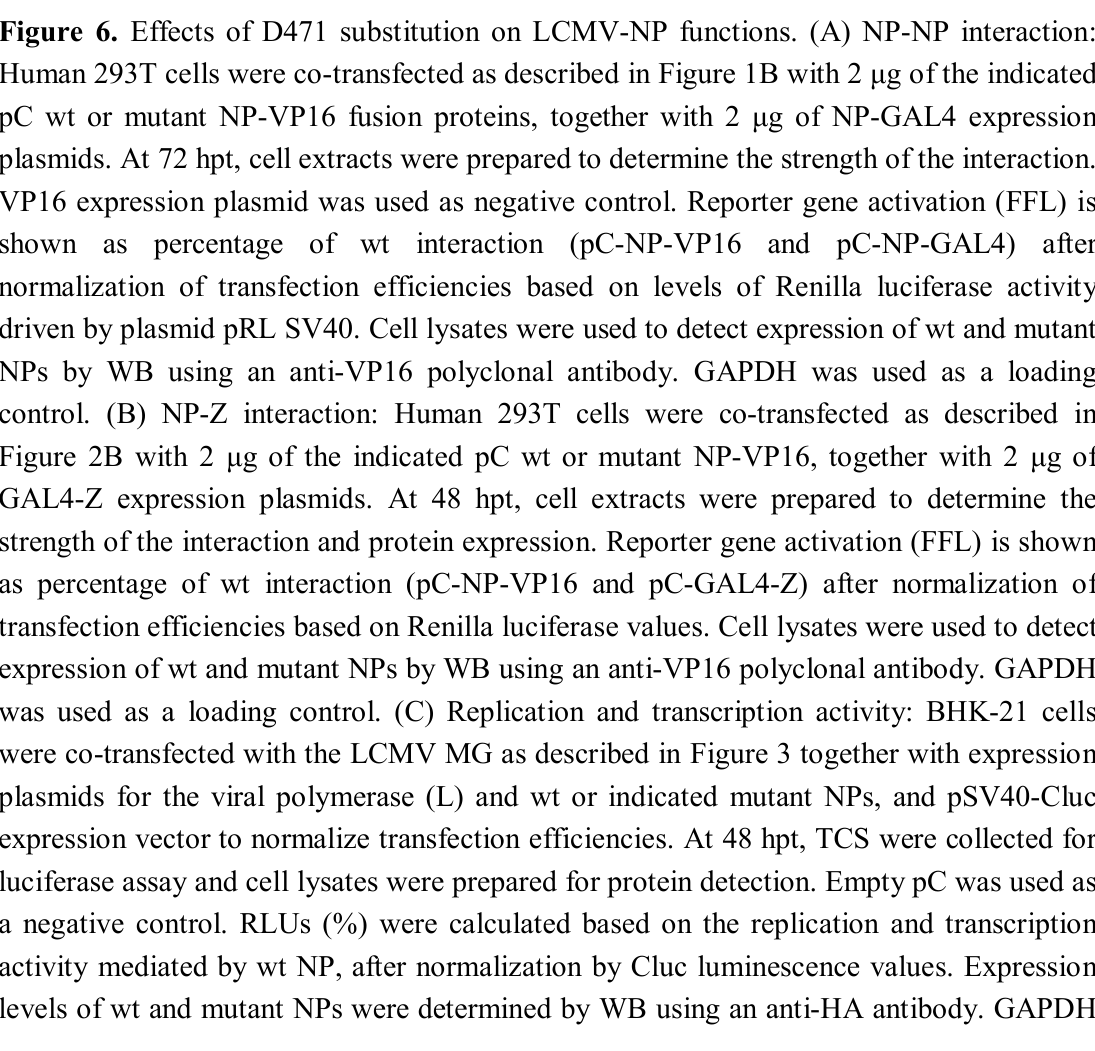
Figure 6. Effects of D471 substitution on LCMV-NP functions. (A) NP-NP